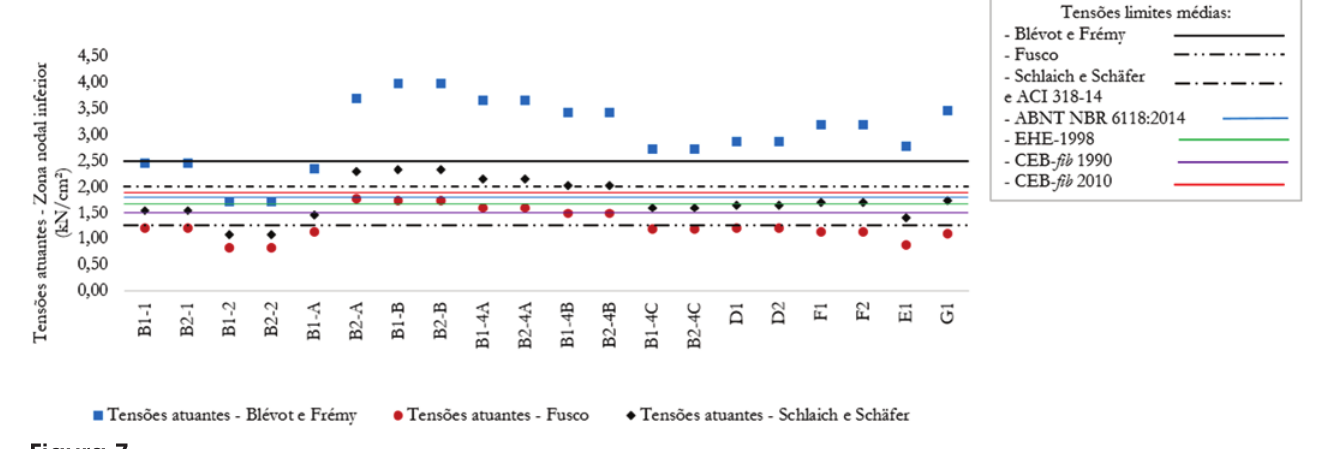
Figura 7 Modelos ensaiados por Mautoni [5] × σ